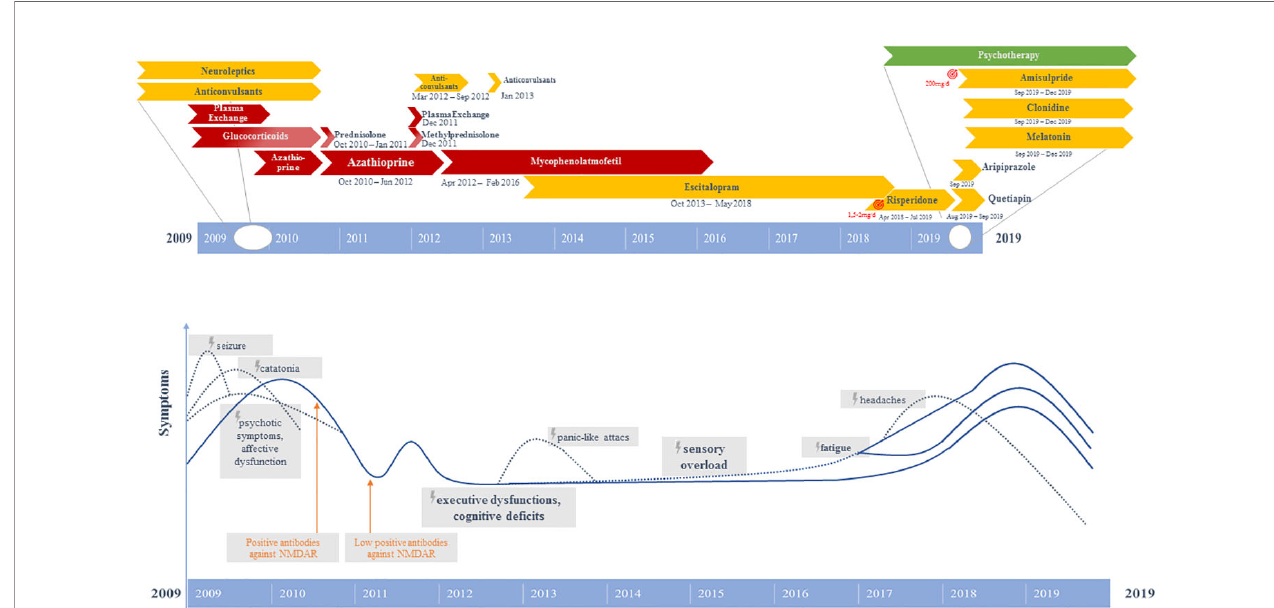
FIGURE 1 | Graphical representation of the clinical course and therapeutic procedures. Above: Different pharmacological strategies. Below: Symptom